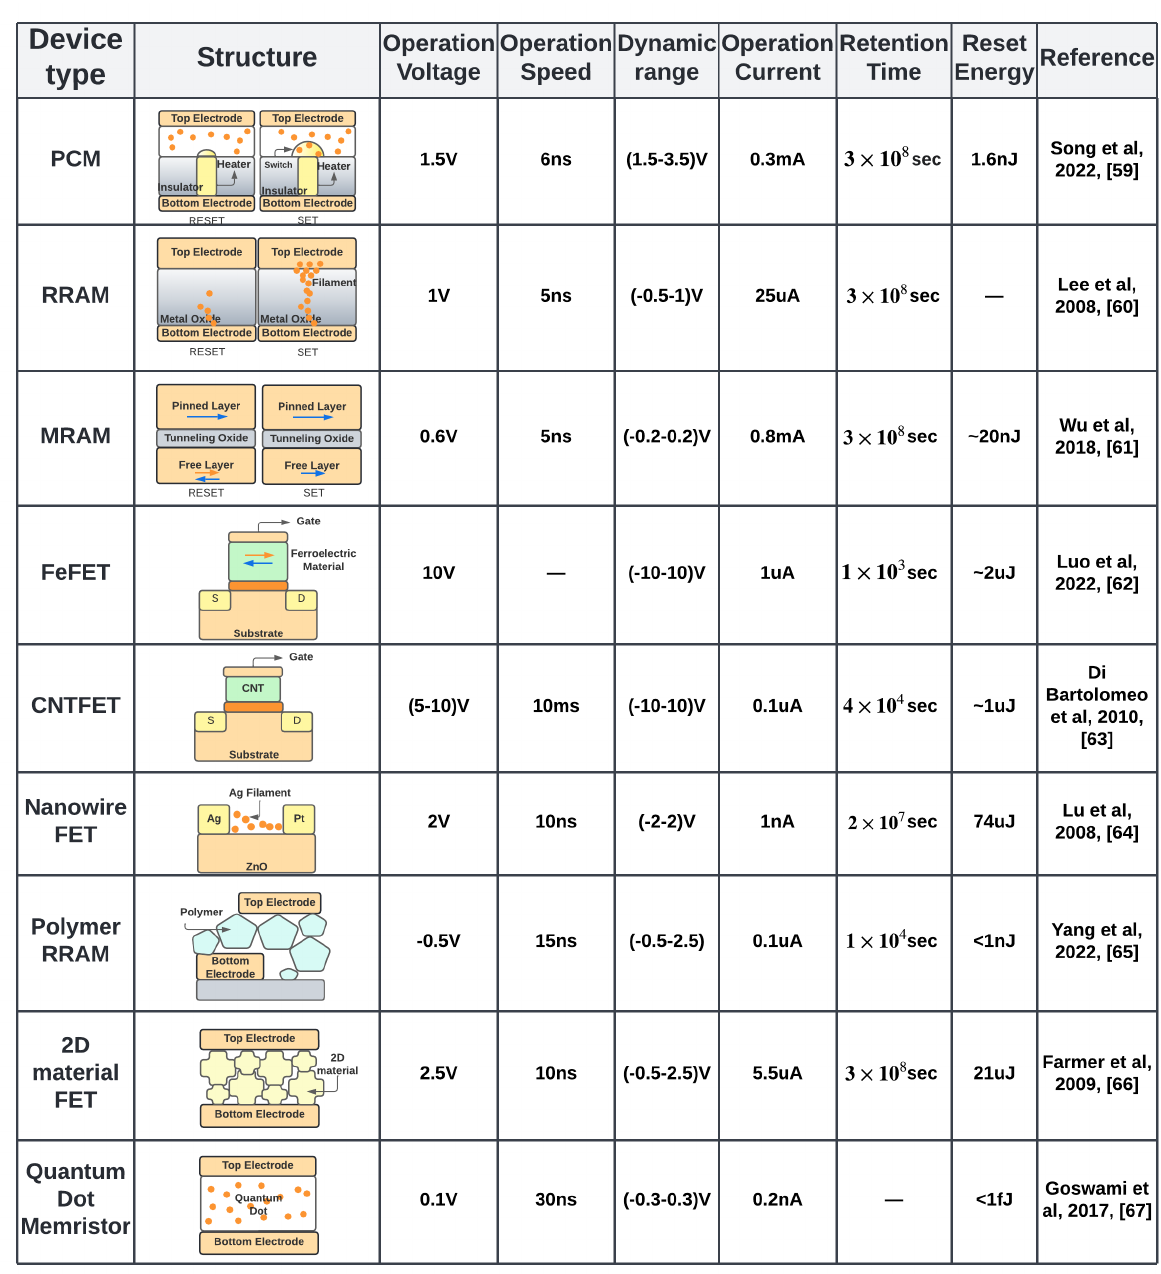
Figure 1. Device-level operation parameters of different NVMs where operation voltage, speed and current are reported for the ON state of the device while dynamic range is the (OFF–ON) voltage range